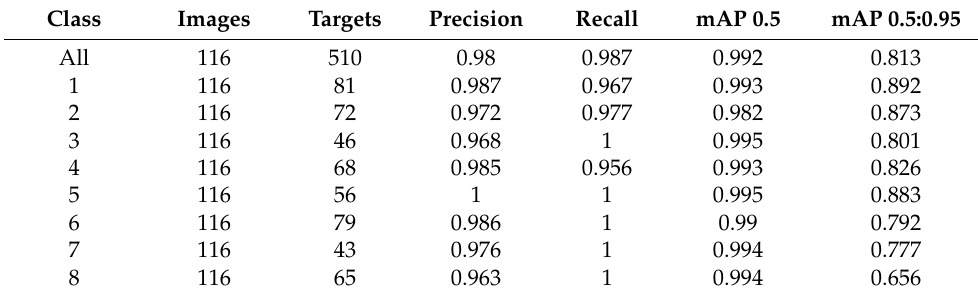
Table 4. Performance of the model YOLOv5s for first dataset (582 images). Class Images